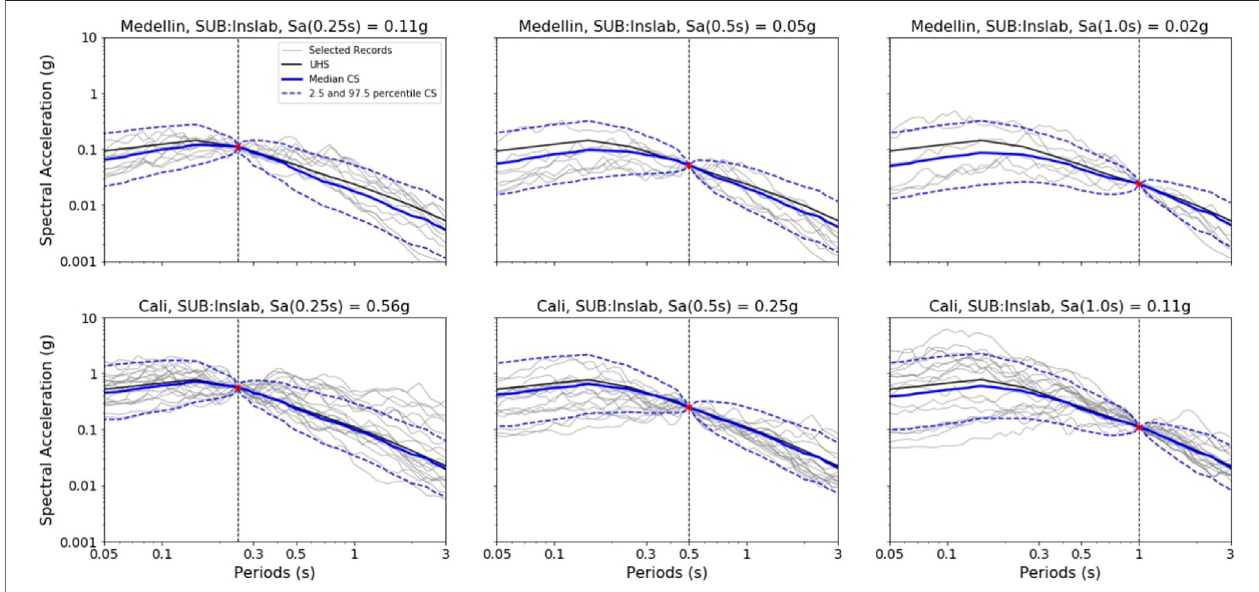
FIGURE 6 | Conditioned spectra (CS), response spectra from the records selected, and uniform hazard spectra (UHS) for subduction intraslab at the intensity measure level of 10% probability of exceedance in 50 years for Sa (0.25 s) left, Sa (0.5 s) center, and Sa (1.0 s) right for the cities: Medellín (top) and Cali (bottom). Continuous blue thick line: median CS. Dash-lines: 2.5 and 97.5 CS percentiles. Continuous gray thin lines: records selected.